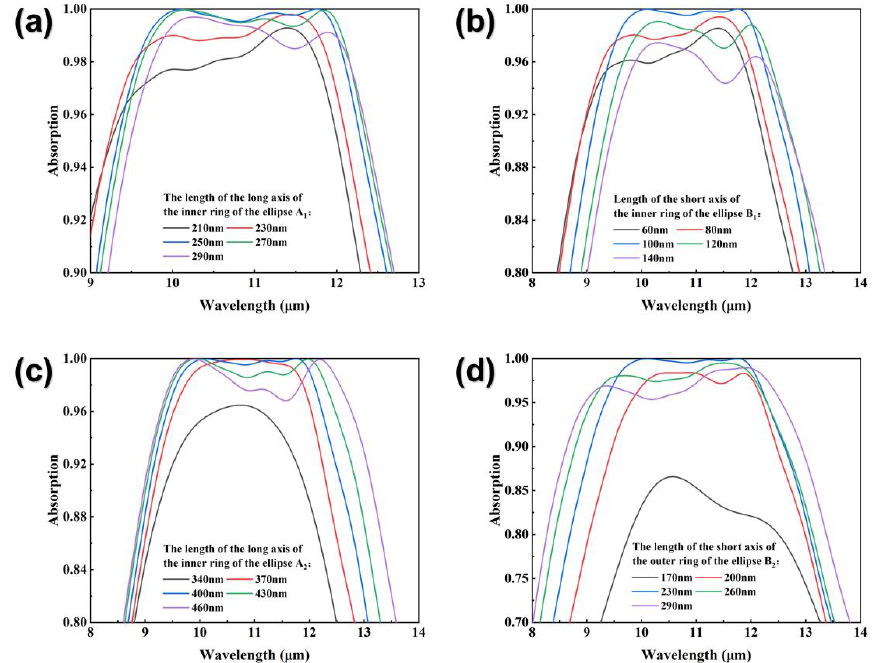
Figure 7. ( a ) Absorption spectra with different long axes of the inner ring of the elliptical ring. ( b ) Absorption spectra with different short axes of the inner ring of the elliptical ring. ( c ) Absorption spectra with different long axes of the outer ring of the elliptical ring. ( d ) Absorption spectra with different short axes of the outer ring of the elliptical ring.